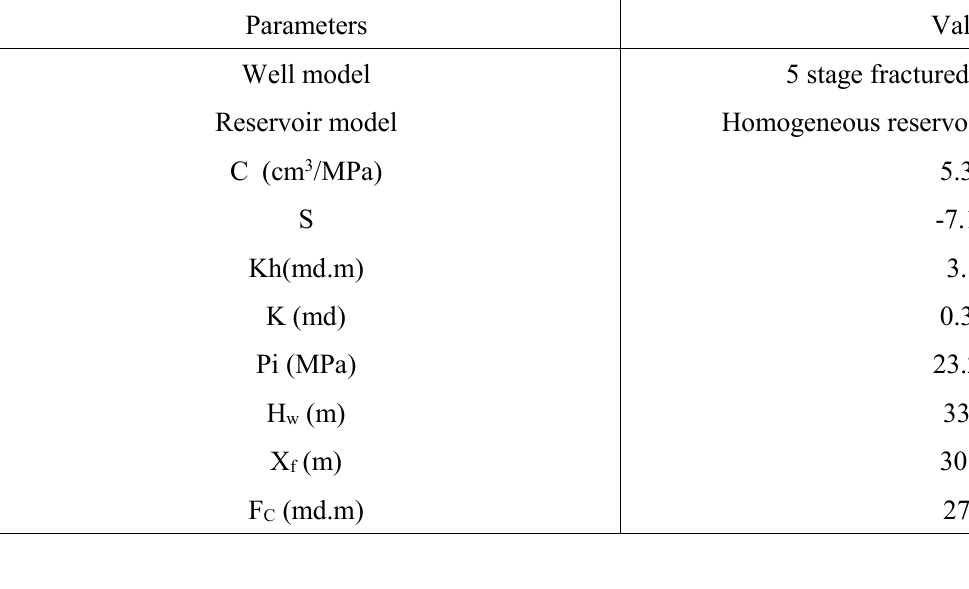
Table 1—Analytical well test interpretation results of SuA-B-CH2 well.